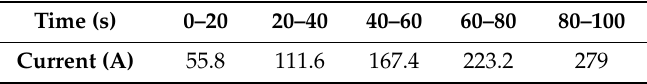
Table 2. Current density used in the simulation process.